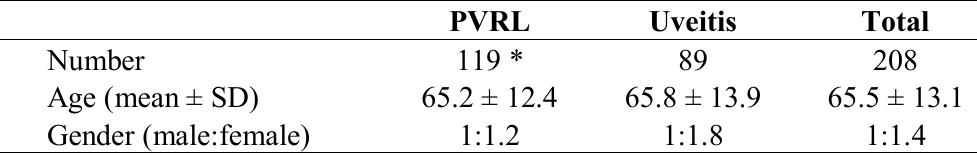
Table 2. Demographics in patients of masquerade